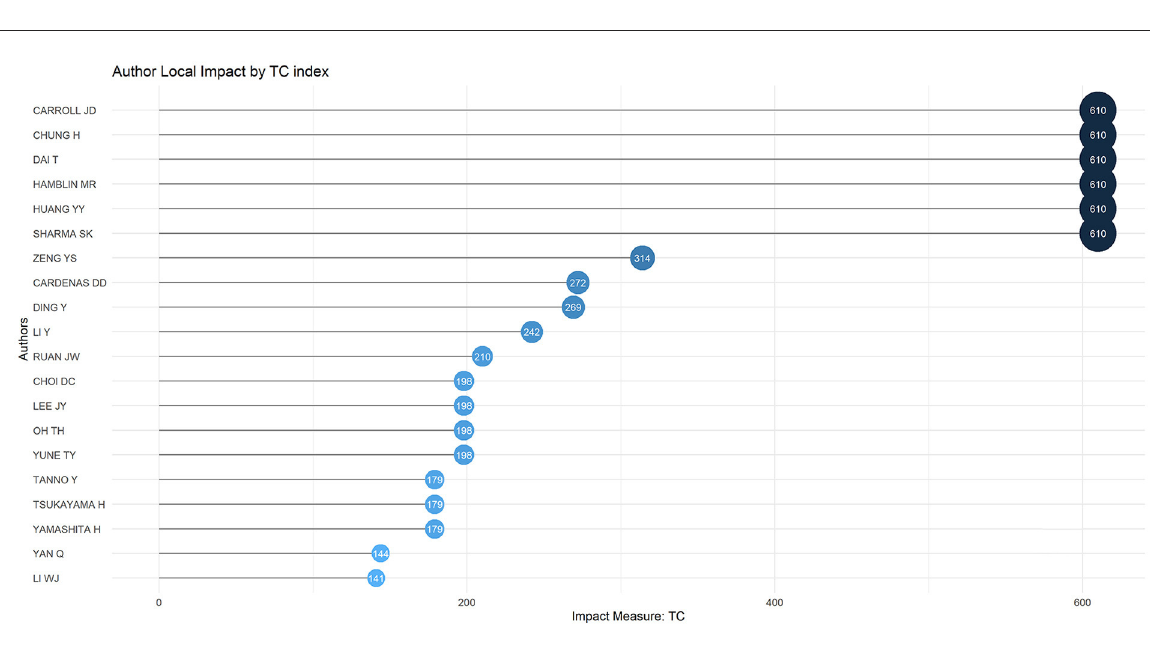
FIGURE5 Author local impact on acupuncture for